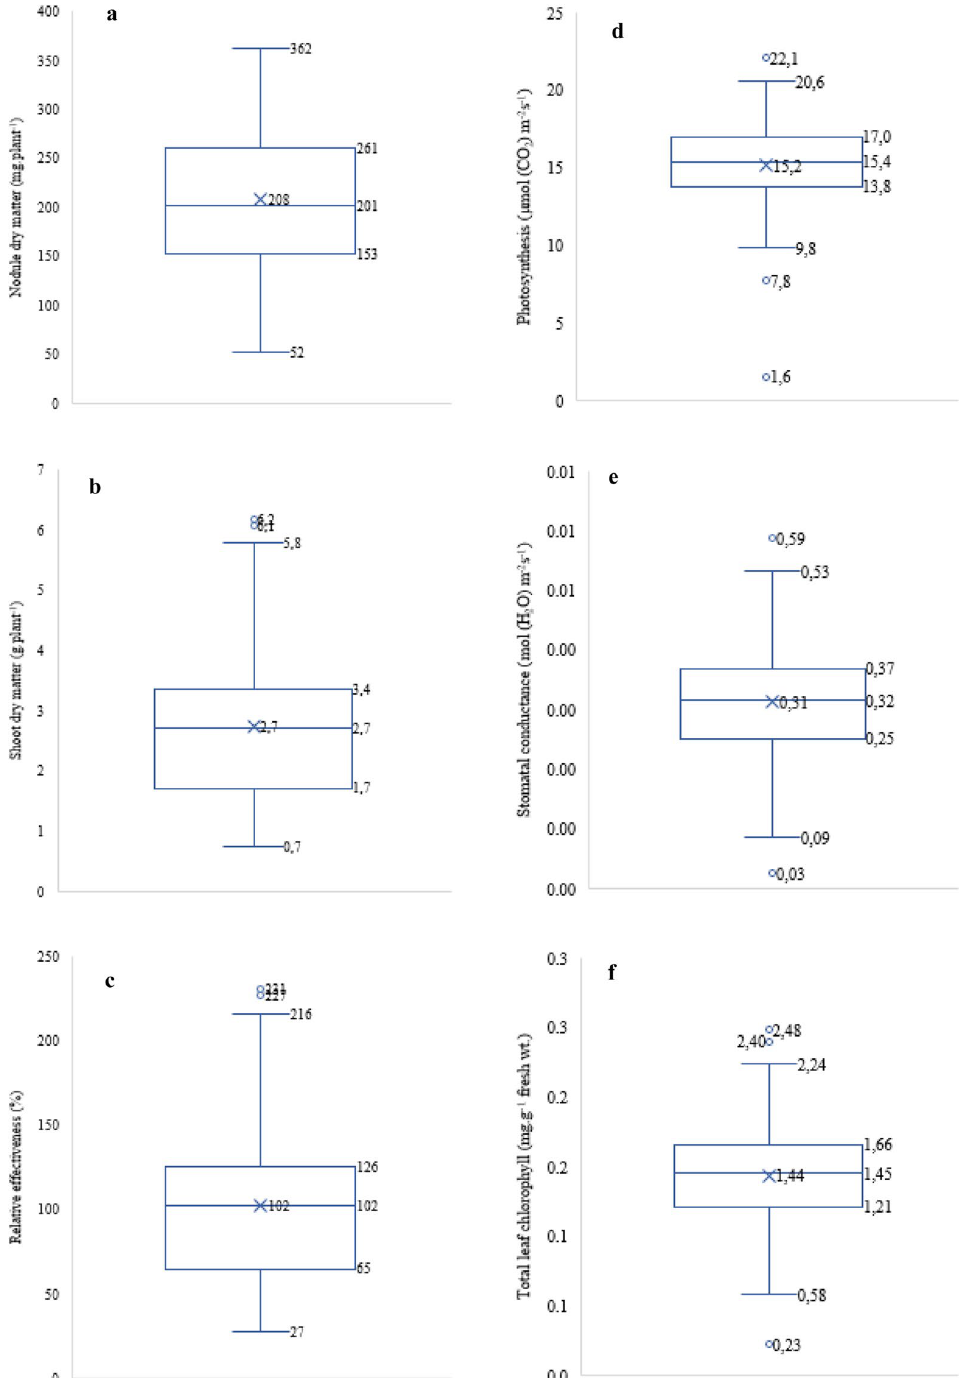
Figure 7. Box plots showing the distribution of ( a ) nodule dry matter, ( b ) shoot dry matter, ( c ) relative effectiveness, ( d ) photosynthetic rates, ( e ) stomatal conductance and ( f ) leaf transpiration rates induced by indigenous Bambara groundnut isolates from Ghana, South Africa and Mali. Centre lines show the medians; X indicates the mean; box limits indicate the lower (Q1) and upper (Q3) quartiles; whiskers extend 1.5 times the interquartile range from the lower and upper quartiles, outliers are represented by